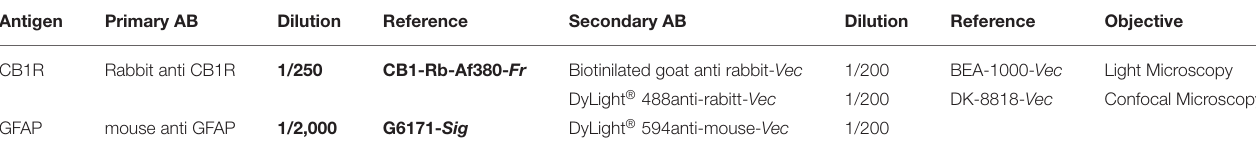
TABLE 2 | List of antibodies used.